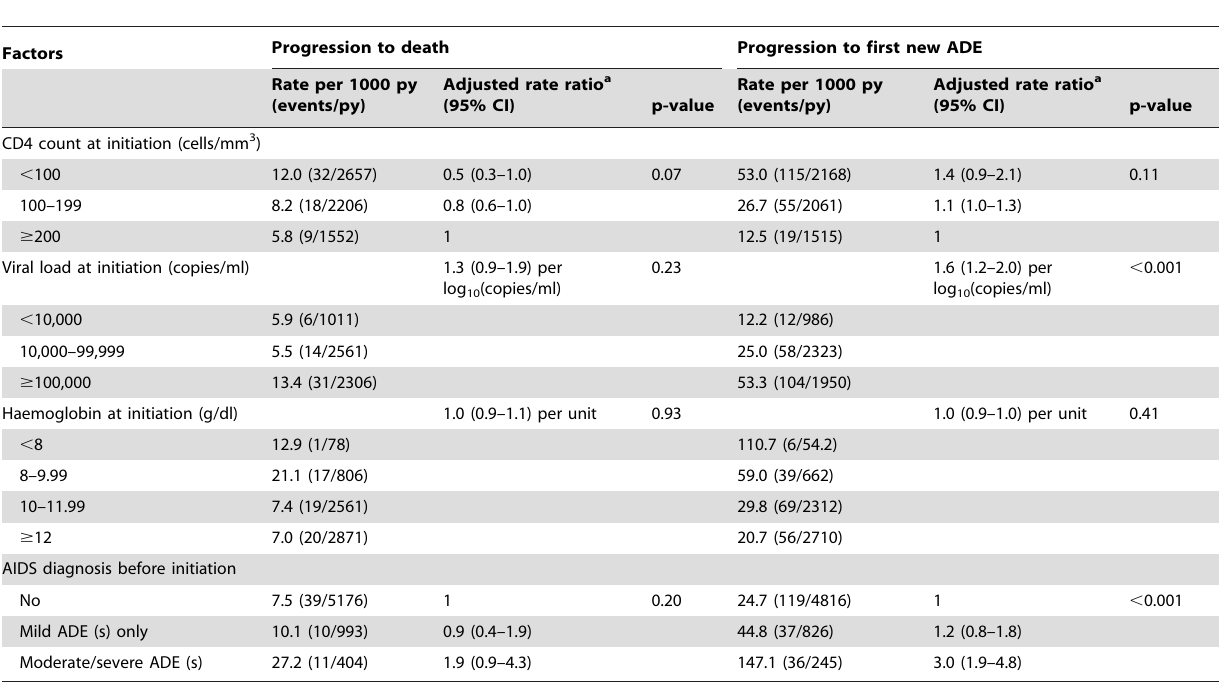
Table 4. Predictive effects of factors at cART initiation on progression to death and to new ADE, adjusted for current CD4 count, haemoglobin and viral